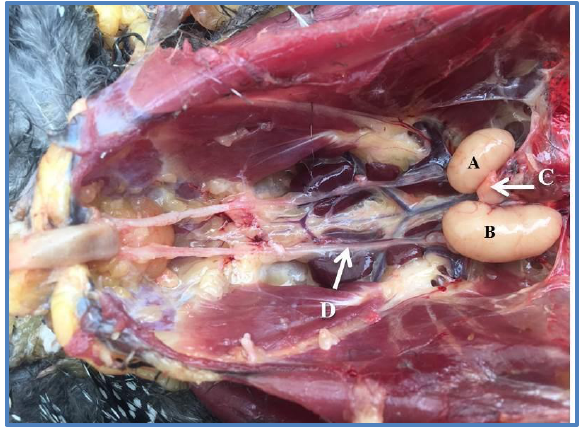
Figure,1: Gross appearance of celomic cavity of guinea fowl showing: right testis (A), left testis (B) epididymis (C)left ureter(D)